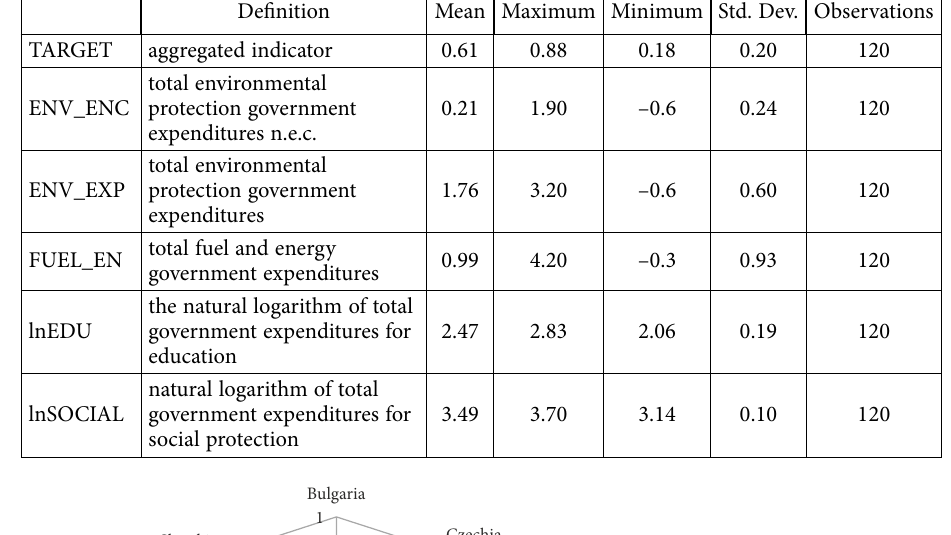
Table 3. Variable definition and descriptive statistics (source: author’s own